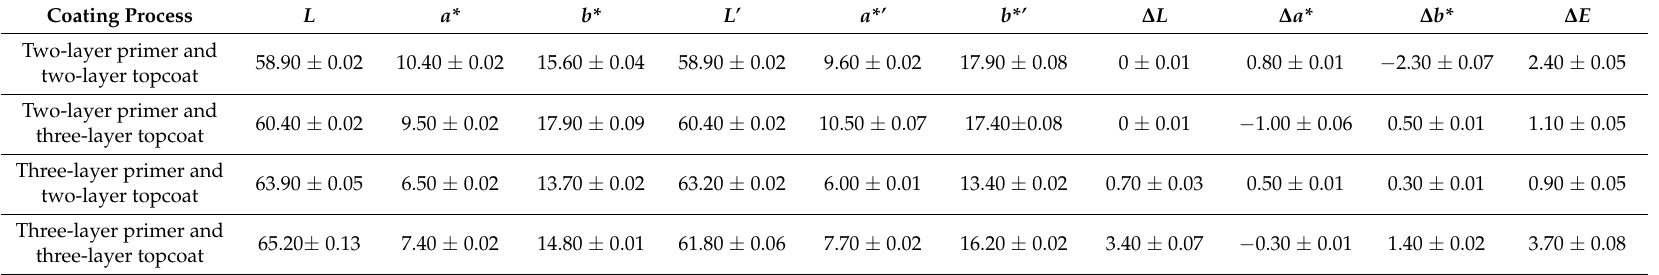
Table 3. Effect of microcapsules in primer on color difference of waterborne coating.